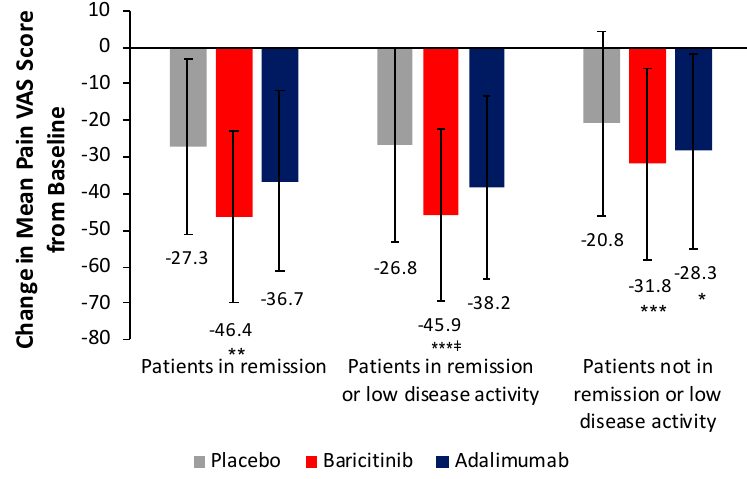
Figure 1. Change from baseline in pain VAS score at week 24 by remission status in patients from RA-BEAM. * p < 0.05, ** p < 0.01, *** p < 0.001 vs. placebo; ‡ p < 0.05 vs. adalimumab. Error bars indicate standard deviation. Change in pain VAS score based on numbers of patients from RA-BEAM in remission (DAS28-ESR < 2.6): PBO + MTX n = 24, BARI + MTX n = 87, ADA + MTX n = 57; in remission or low disease activity (DAS28-ESR ≥ 2.6 and ≤ 3.2): PBO + MTX n = 46, BARI + MTX n = 154, ADA + MTX n = 110; and not in remission or low disease activity: PBO + MTX n = 276, BARI + MTX n = 266, ADA + MTX n = 157. One patient was missing from the BARI + MTX group for patients not in remission or low disease activity. ADA adalimumab, BARI baricitinib, DAS28-ESR Disease Activity Score for 28-joint count with erythrocyte sedimentation rate, PBO placebo, MTX methotrexate, VAS visual analogue scale.